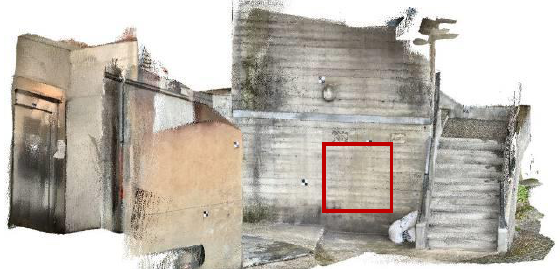
Figure 6 . Example of the matrix of point of the max area low resolution static acquisition. In red the vertical distance and in blue the horizontal distance between two adjacent points.